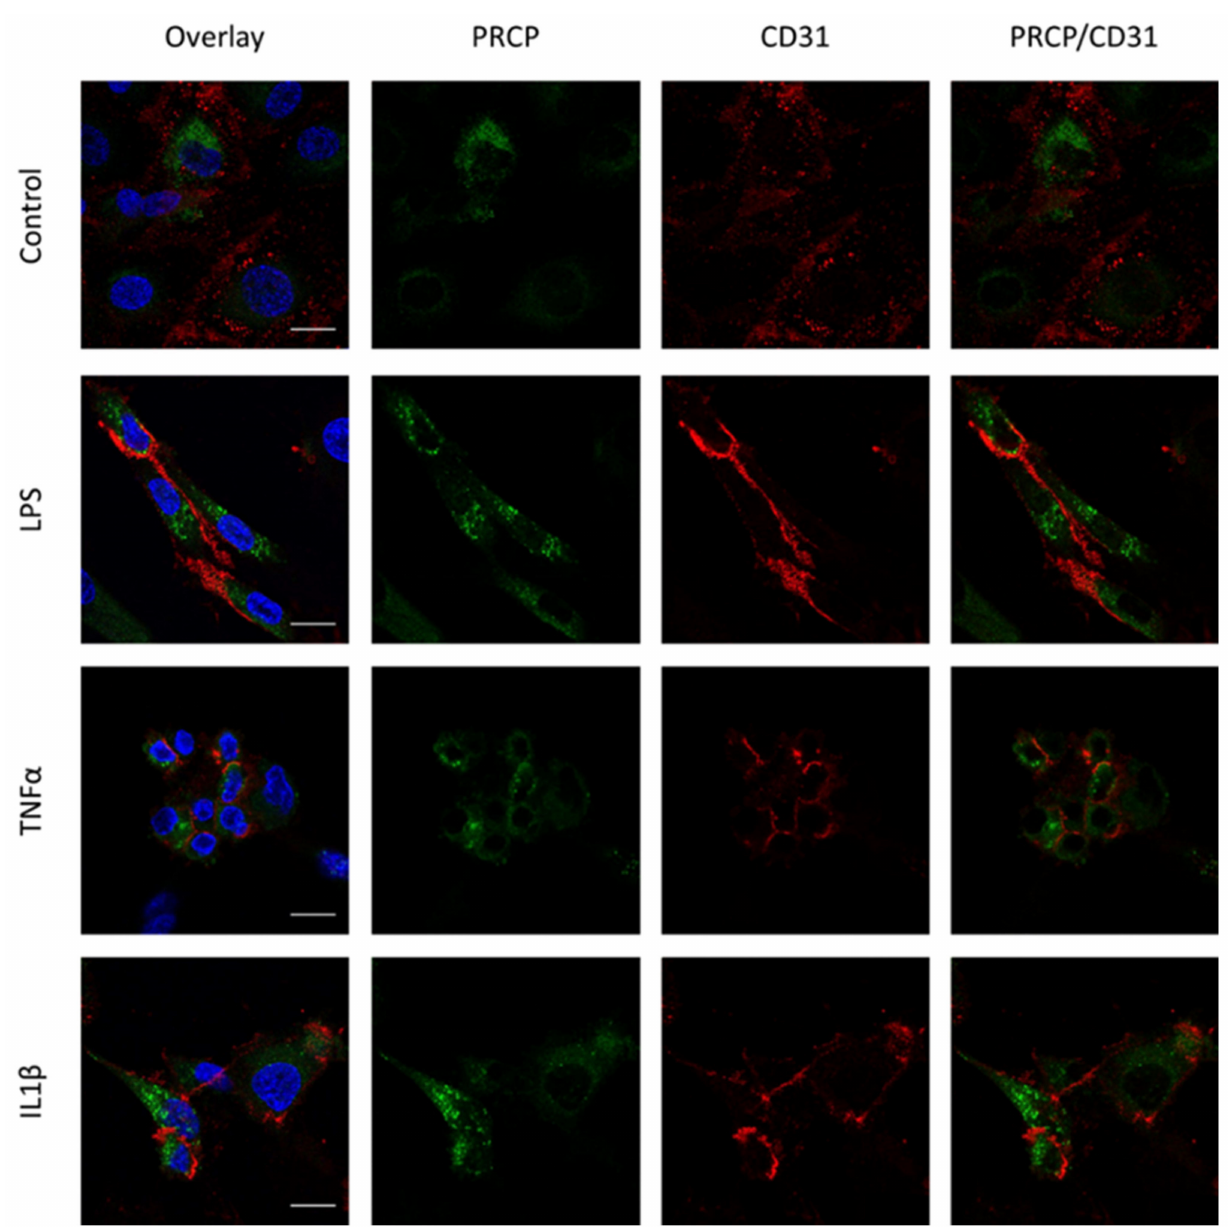
Figure 4. Overlap between PRCP and CD31 is not observed in HUVEC. Double staining of PRCP and CD31 in control, LPS-, TNF α - and IL-1 β -stimulated permeabilized HUVEC. Cells were incubated for 16 h with the different stimuli, fixed with 4% PFA, permeabilized with 0.1% Triton X-100 and stained for PRCP (green), CD31 (red), and DAPI (nuclear marker, blue). Representative images of three independent experiments. Non-permeabilized cells showed comparable results. (bar = 20 µ